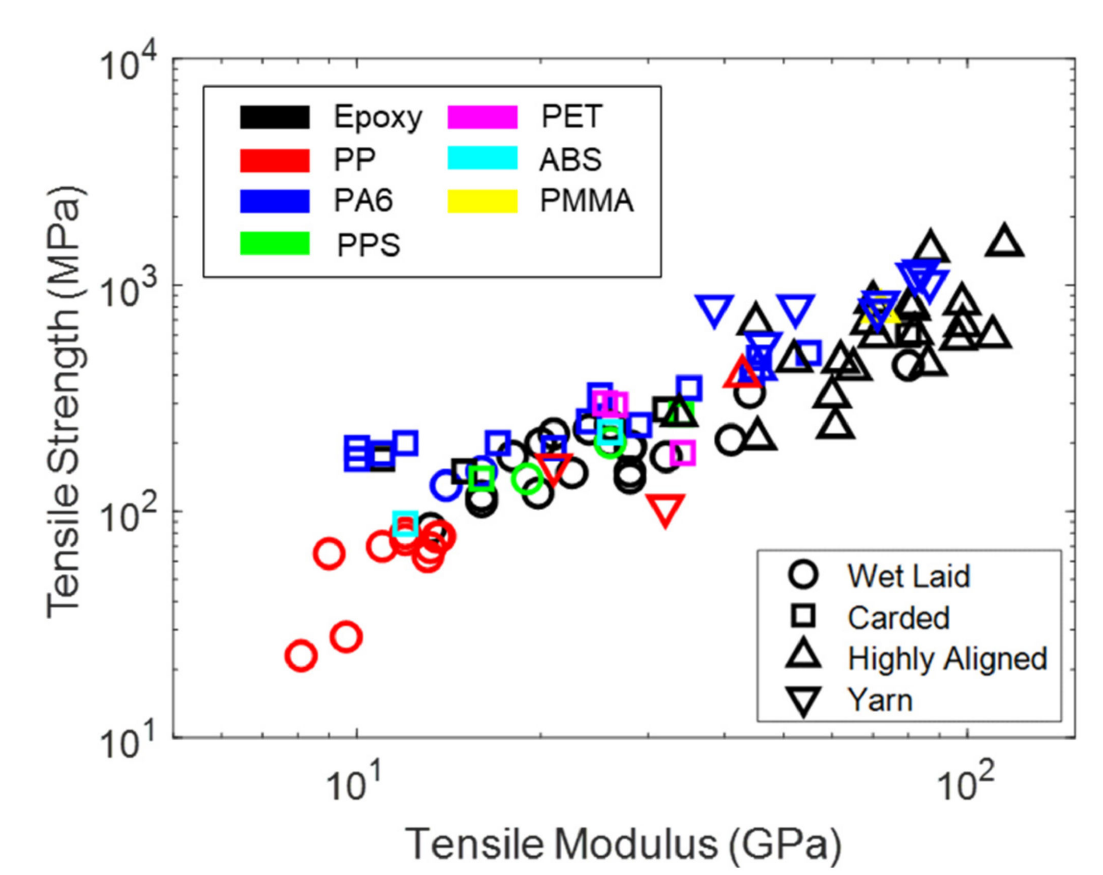
Figure 9. Ashby plot of various recycled carbon fiber composites from literature [24,26,27,29–32,34–45,49–51,54,59,61,62,65–